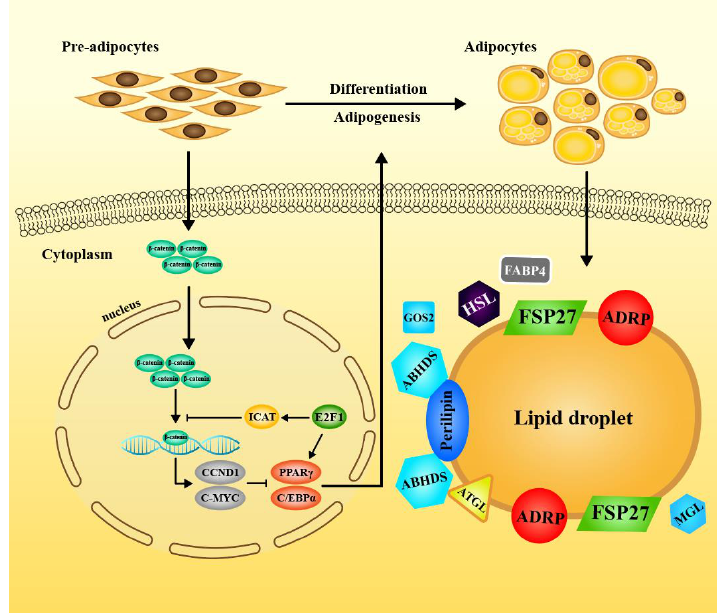
Figure 7. Proposed model on crosstalk between E2F1/ICAT and Wnt/β-catenin signaling on the differentiation of pre-adipocytes. The stabilized free cytosolic β-catenin translocate to the nucleus to interaction with the TCF4 for activation of the Wnt/β-catenin targets and inhibit adipogenesis by blocking induction of C/EBP and PPAR proteins. The activating ICAT by E2F1 competes with the β-catenin to repress the β-catenin-TCF4-mediated transactivation instead of directly downregulating the β-catenin expression, and reverses the inhibitory effect of Wnt/β-catenin signaling on MDI-induced adipogenesis. ICAT activation downregulates the protein expression of c-MYC and CCND1 and abolishes their suppression on protein expression of C/EBPα and PPARγ, thus functioning as a promotive regulator for adipogenesis during differentiation.